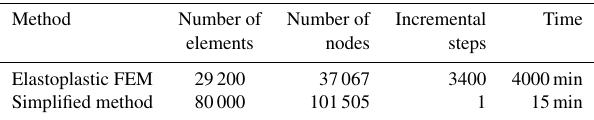
Table 4. Comparison for elastoplastic FEM and simplified defor- mation simulation method (two